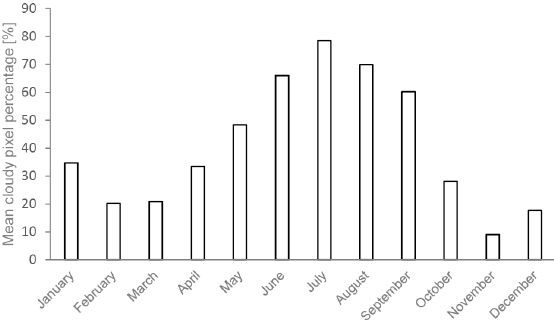
Figure A2. Mean cloudy pixel percentage of all Sentinel-2 images taken over the assessment site during the respective month. For each month, 5 consecutive years were analyzed. The plotted values represent the average of these 5 years.